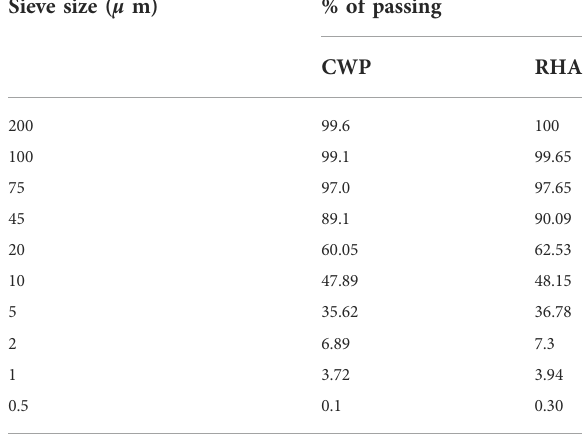
TABLE 4 Sieve analysis of CWP and